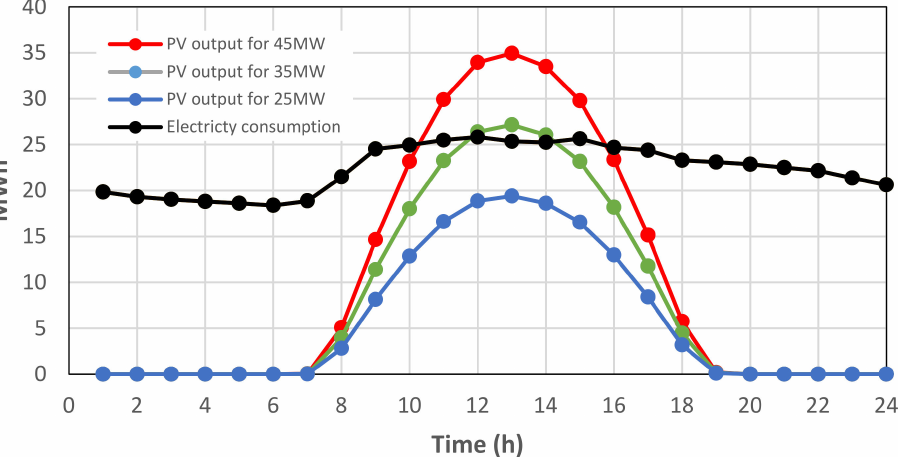
Figure 12. Average hourly profiles of total photovoltaic power output in March for 25 MW of PV capacity, 35 MW of PV capacity and 45 MW of PV